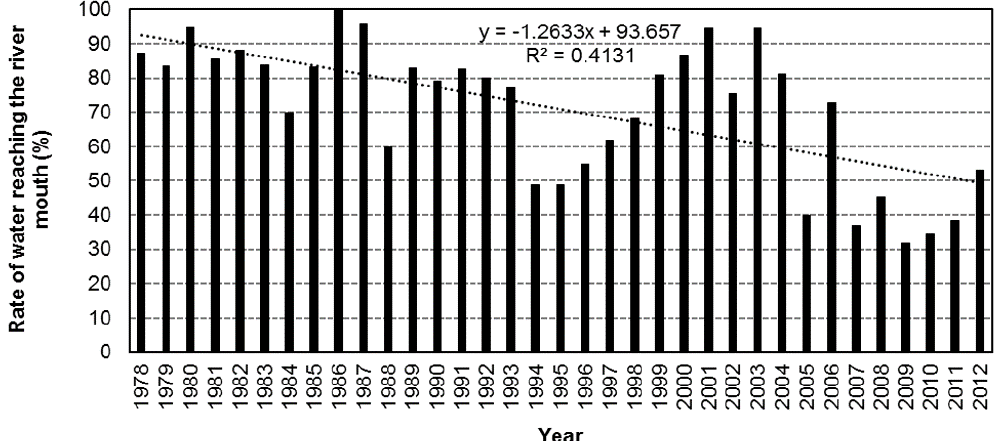
Figure 6. Days of water reaching the river mouth of Kamo River from 1978–2012.